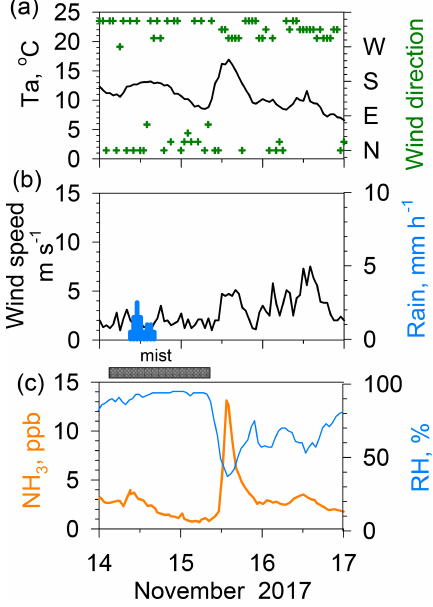
Figure 6. Effects of rain–mist events on ambient NH 3 concentra- tions during 14–17 November 2017. (a) Temperature and wind di- rection. (b) Wind speed and rain rate. (c) NH 3 and relative